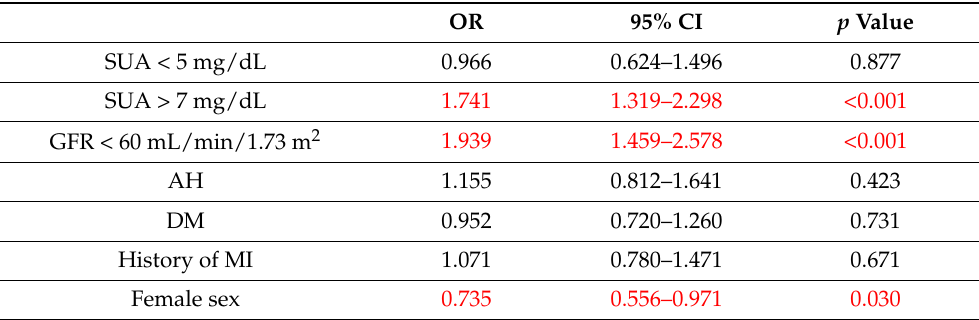
Table 4. Markers of EF < 40%. Results of multivariate regression analysis.